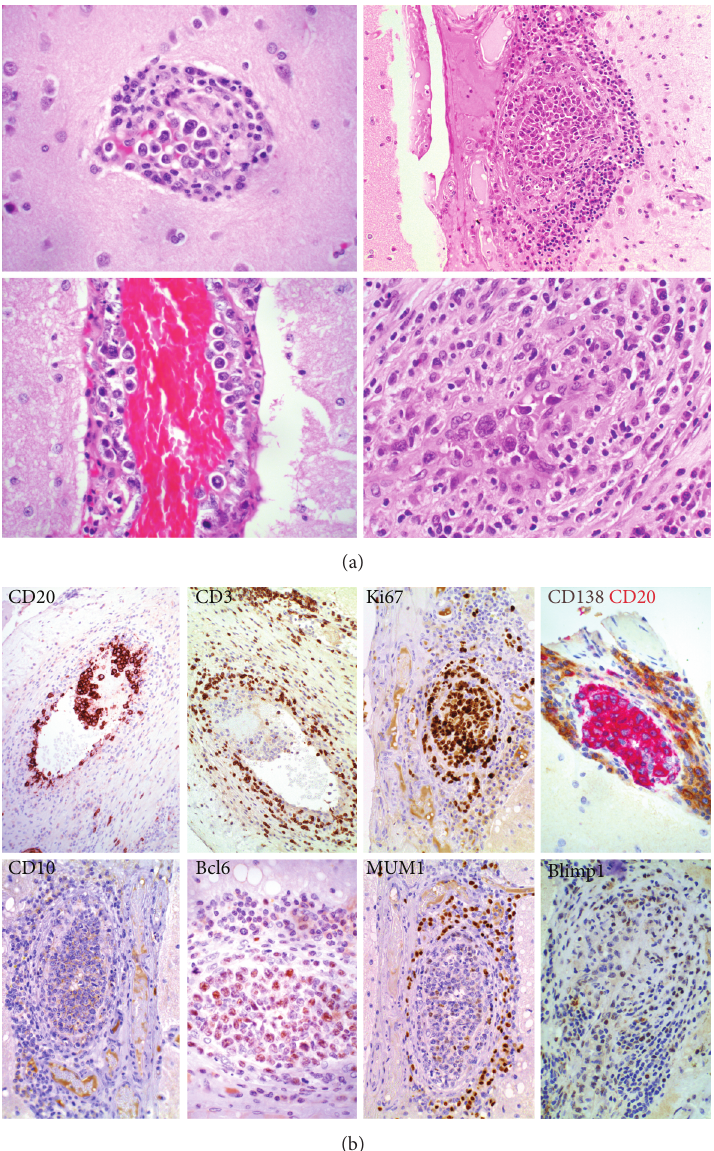
Figure 2: (a) Intravascular large B-cell lymphoma of brain. Hematoxylin and eosin (H/E) staining highlights intravascular large B-cell lymphoma in the brain, featuring large cells with moderate pleomorphism, vesicular chromatin, and prominent nucleoli. (b) Intravascular large B-cell lymphoma of brain. Immunohistochemistry confirms the B-cell lineage of the intravascular large cell lymphoma, being CD20+ CD3 − and showing a high proliferation fraction by staining for Ki67. It displays a germinal centre phenotype by Hans’ criteria, being CD10 − bcl6+ MUM1 − and lacks blimp1